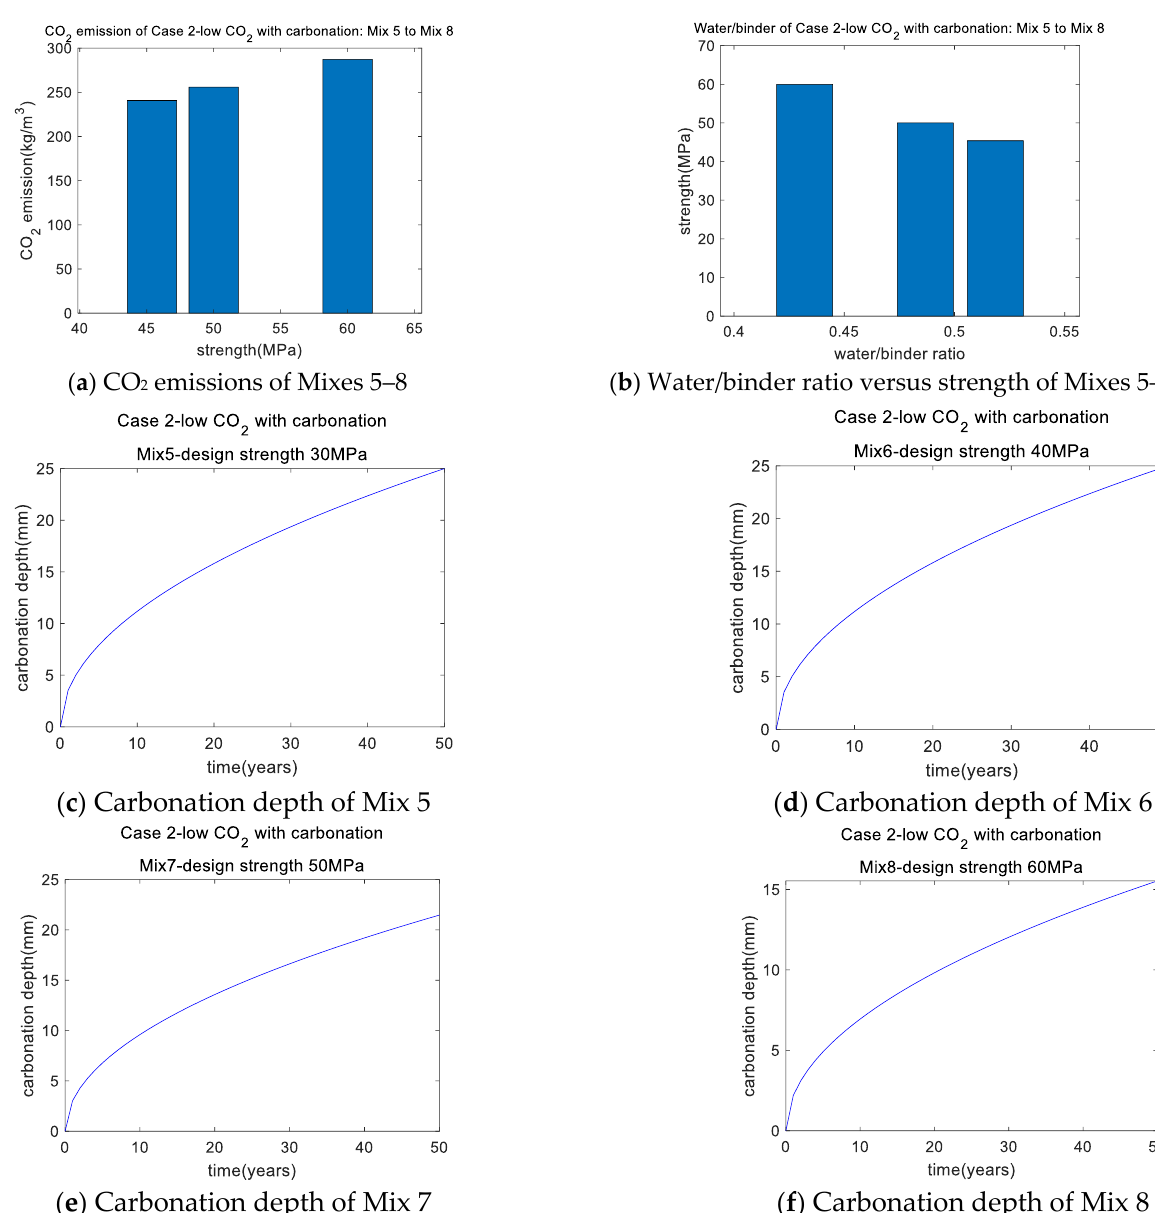
11.39 Table 9. Performance of optimal design mixtures for Case 2: low-CO 2 concrete with carbonation. Strength (MPa)